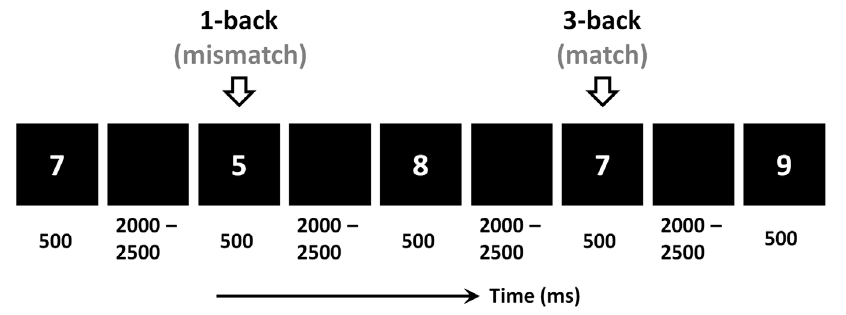
Figure 1. Illustration of the n-back paradigm (n=1 and 3) in this study.